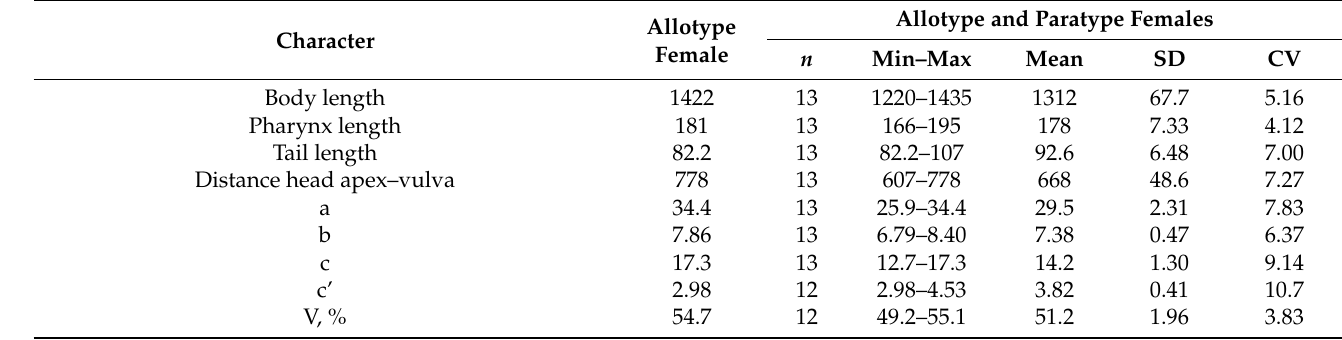
Table 8. Morphometrics of females Acanthopharynx parva sp. n. from samples PA13 and PA21